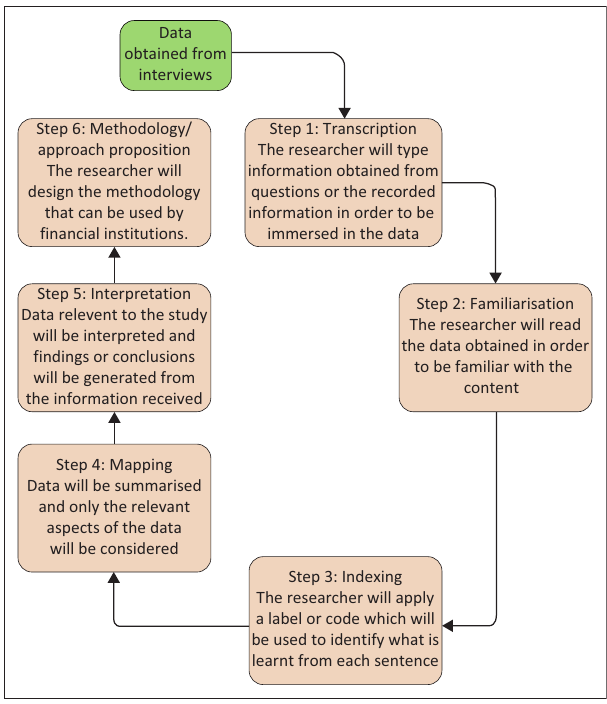
FIGURE 1: Qualitative data analysis